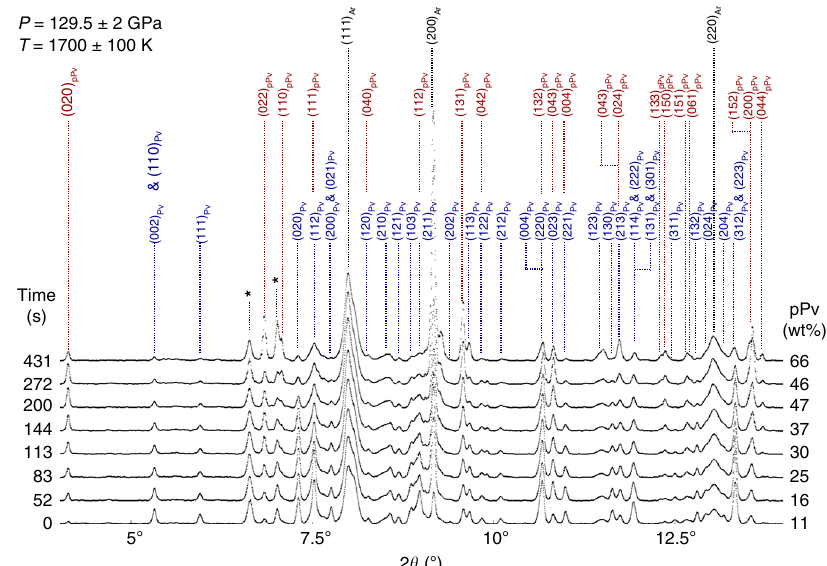
Fig. 1 Time series of X-ray diffraction data collected in (Mg 0.86 ,Fe 0.14 )SiO 3 during phase transformation. Data acquired during the Pv to pPv transformation at 129.5 GPa and 1700 K (Sample #1 in Table 1). Miller indices of most diffraction lines of Pv (blue), pPv (red) and the Argon pressure medium (Ar, black) are indicated on the fi gure. Stars indicate diffraction lines that are not assigned to either phase and do not change during the transformation. Weight proportions of pPv relative to the (Pv þ pPv) assemblage are obtained by a Rietveld re fi nement with the Maud software 60 . 2 θ angle ranges with Ar peaks were ignored in the re fi nements.